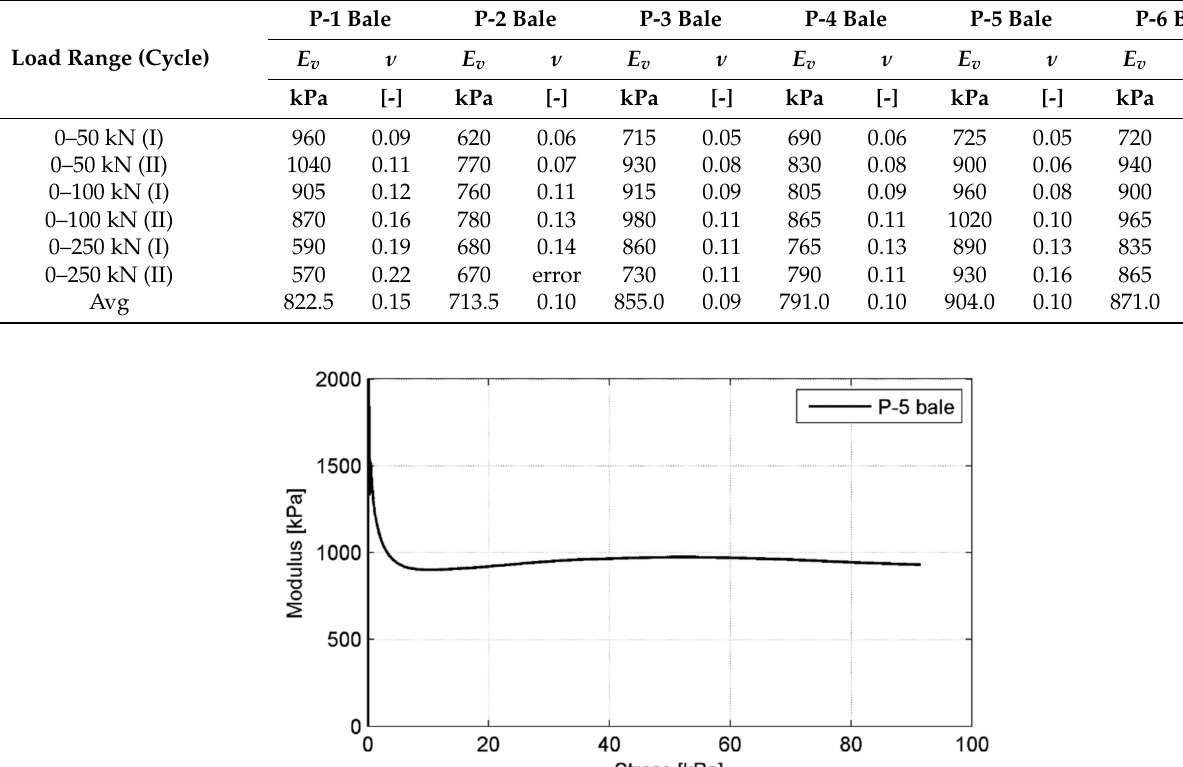
Table 4. Average Young’s moduli and Poisson’s ratios for tested tyre bales.